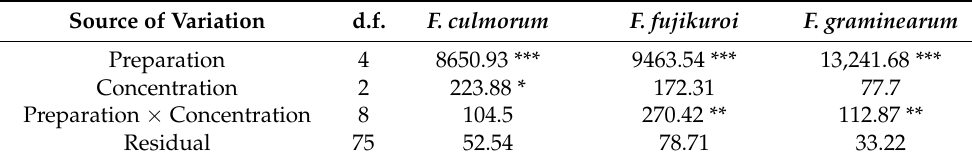
Table 5. Mean squares from two-way analysis of variance for the mycelium colony diameter for the three